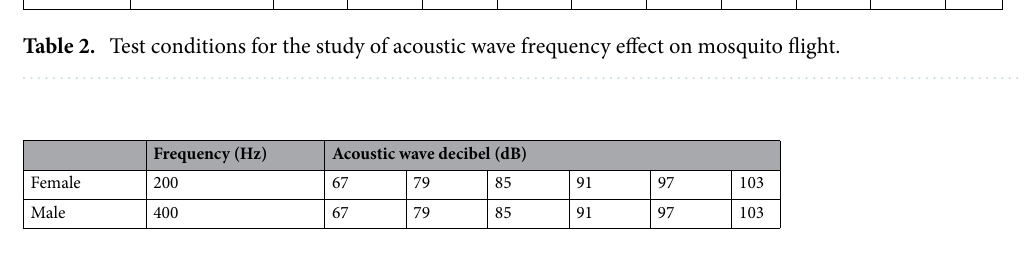
Table 3. Test conditions for the study of acoustic wave Decibel effect on mosquito